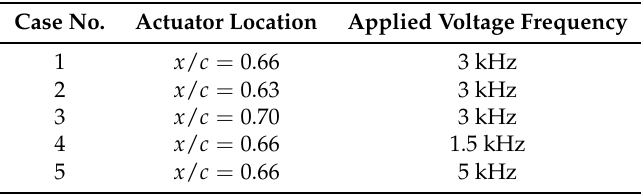
Table 2. Plasma actuator test